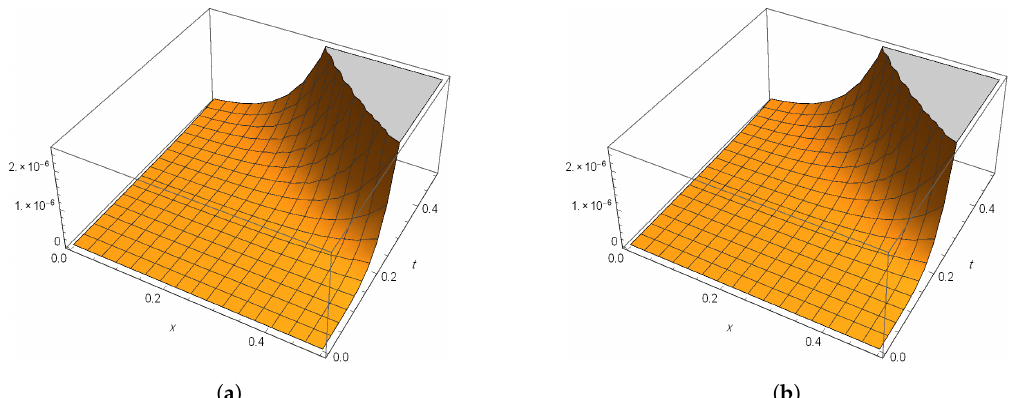
Figure 11. The absolute errors between the exact solutions and the fourth order solutions for α = 1, y = 1 and R = 100 with ( a ) u 4 ( x , y , t ) and ( b ) v 4 ( x , y , t ) .